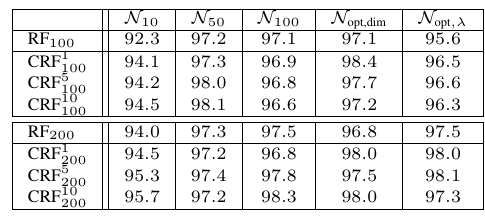
Table 5. Quality q [%] for class g achieved in all experiments. N 10